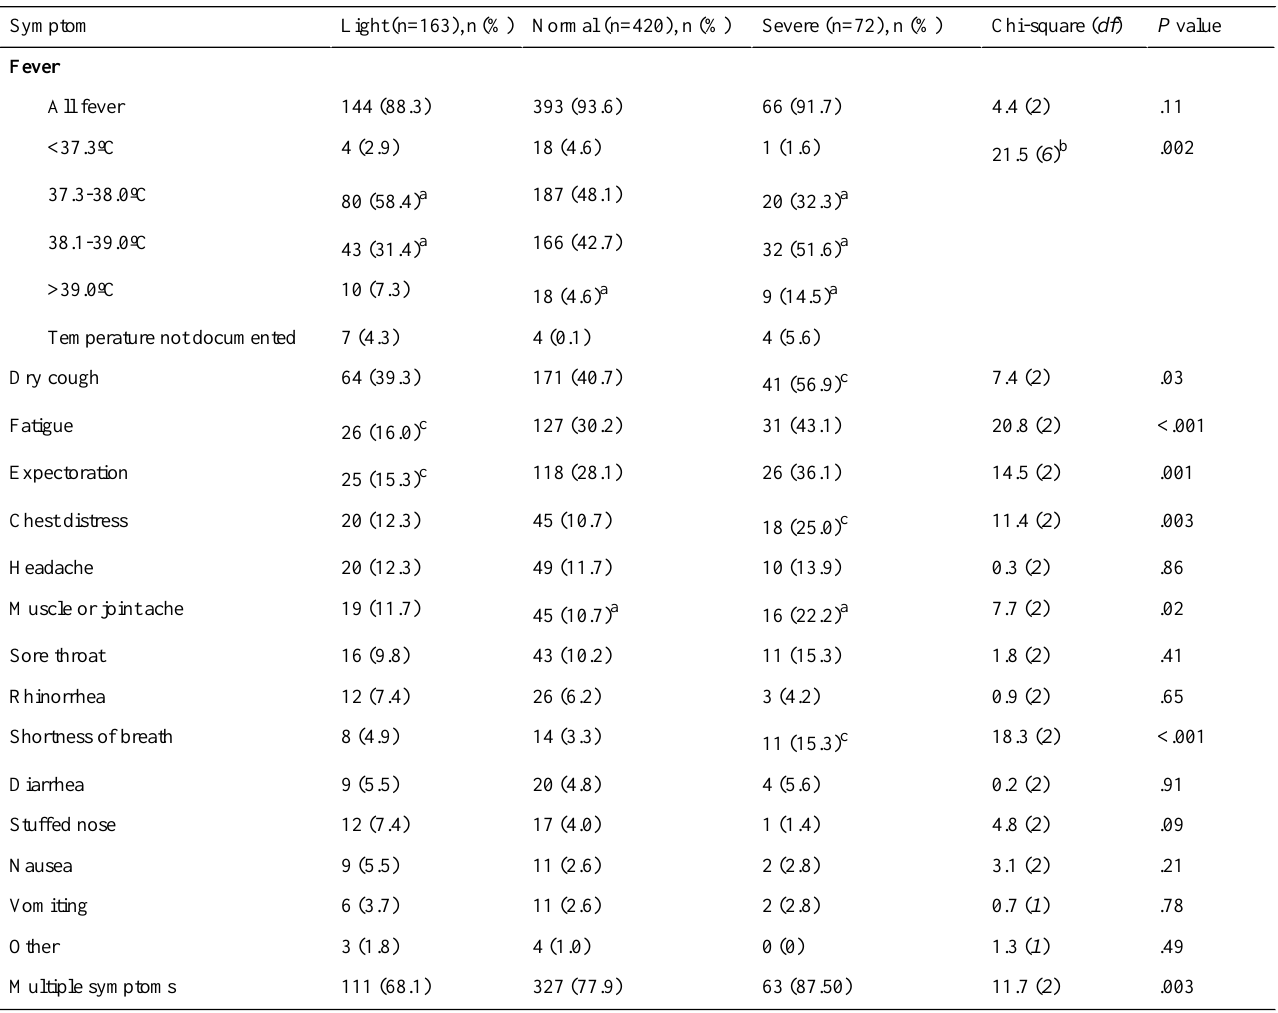
Table 2. Symptoms stratified by disease severity among patients with COVID-19